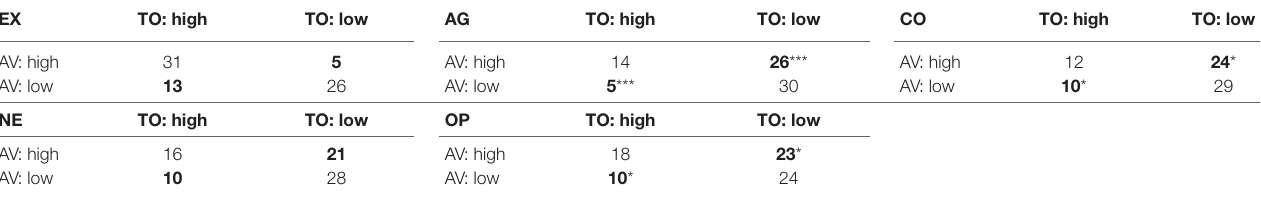
TaBle 5 | contingency tables for each trait (at a significance level of * p < 0.05 and *** p <